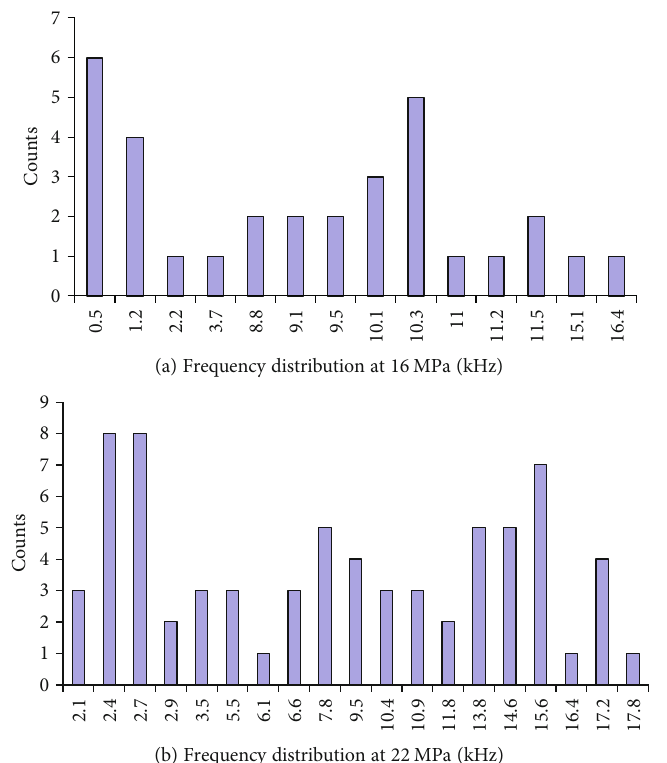
Figure 10: The main frequency distribution of marble under the e ff ects of